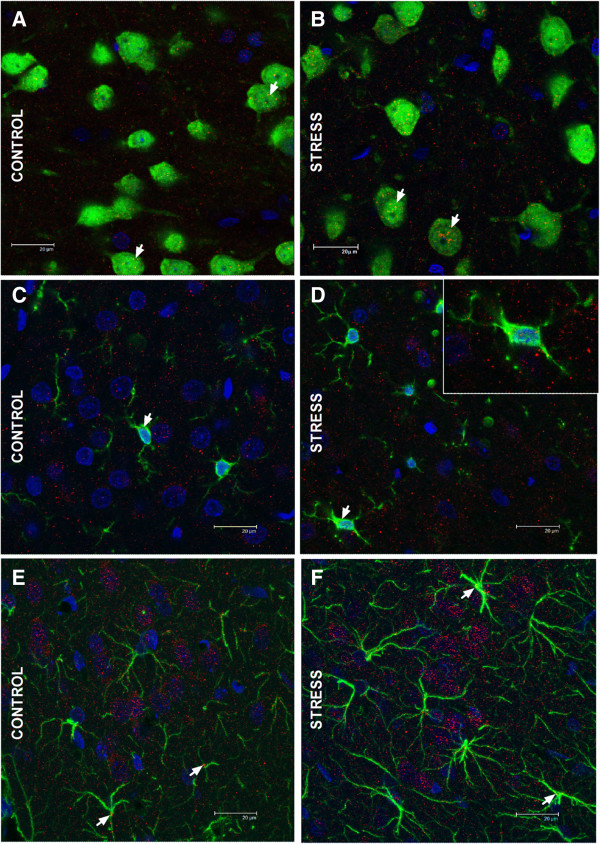
Toll-like receptor-4 immunoreactivity in the brain frontal cortex of rats in control and stress conditions. Sections (30 μm) through the frontal cortext of rats in (A, C, E) control and (B, D, F) stress conditions. The respective cellular markers appear in green: neurons are identified with NeuN (A, B), microglia with IBA-1 (C, D) and astroglia with glial fibrillary acidic protein (E, F). In all cases toll-like receptor (TLR)-4 is marked in red. TLR-4 localizes to the respective cellular marker with some areas of overlap appearing yellow/orange in the merged image (white arrows in A-F). Scale bars: 20 μm.